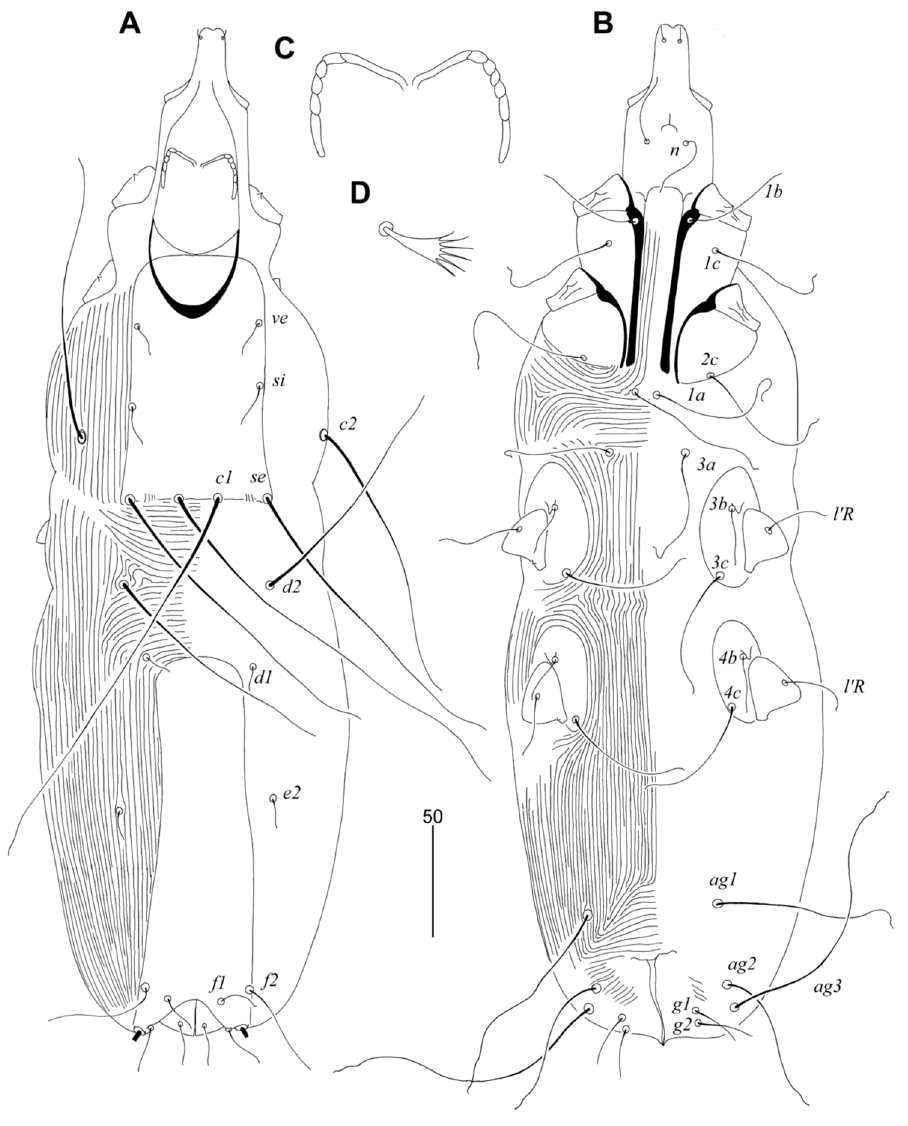
D —fan-like seta p’ Figure 1. Aulonastus darwini sp. n., female: A —dorsal view; B —ventral view; C —peritremes; D — fan-like seta p’ III.